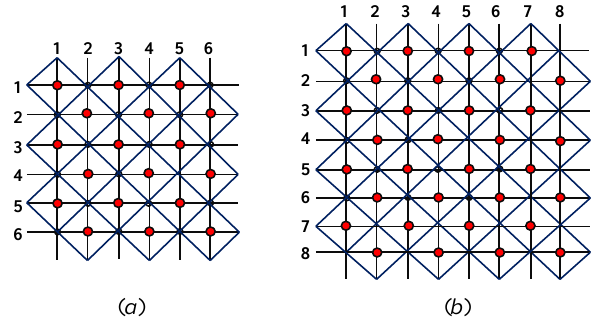
Figure 10. The full coverage of RSUs: ( a ) 6 × 6 intersections; ( b ) 8 × 8 intersections.